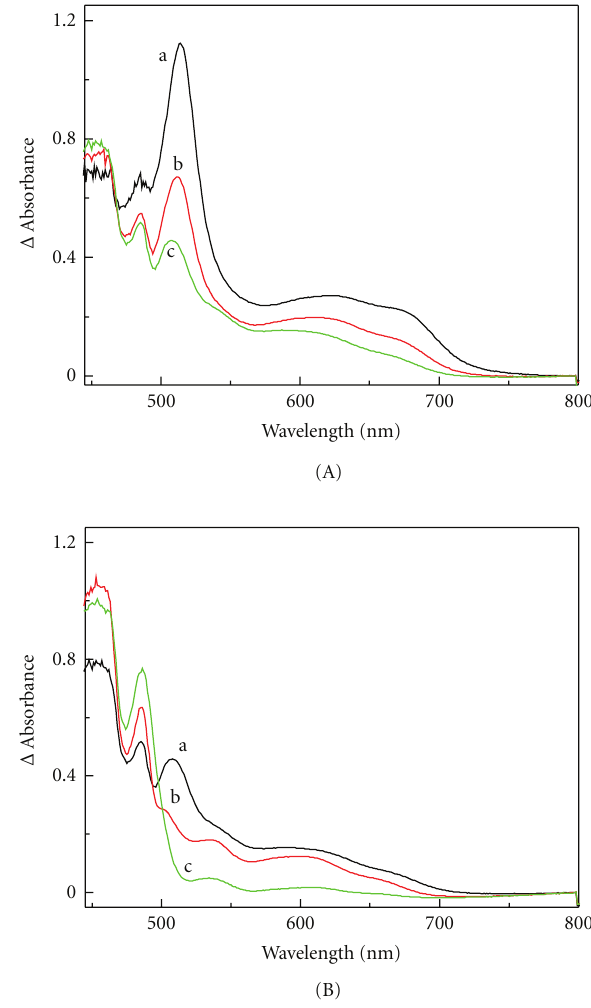
Figure 1: Electronic absorption spectra obtained on oxidation of 1 (saturated solution, < 0.01 M) embedded in a BMIM + PF 6 − :CH 2 Cl 2 (1:1) matrix. (A) spectra were collected after radiolysis at 77K (a) and after annealing of the matrix at 140K for 5min (b) and for 15min (c). (B) After annealing at 140K for 25min (a) and at 150 K for 10min (b) and 20min (c). The sample was 2mm thick and received a radiation dose of 7.2